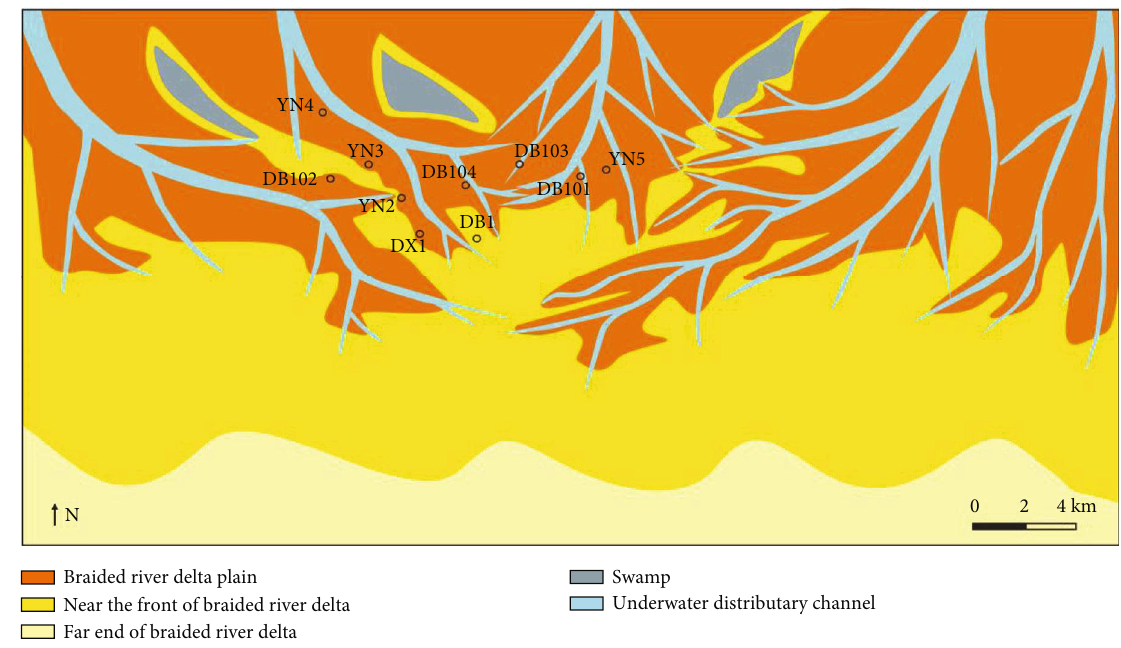
Figure 4: Distribution of Jurassic sedimentary facies in the Dibei block.